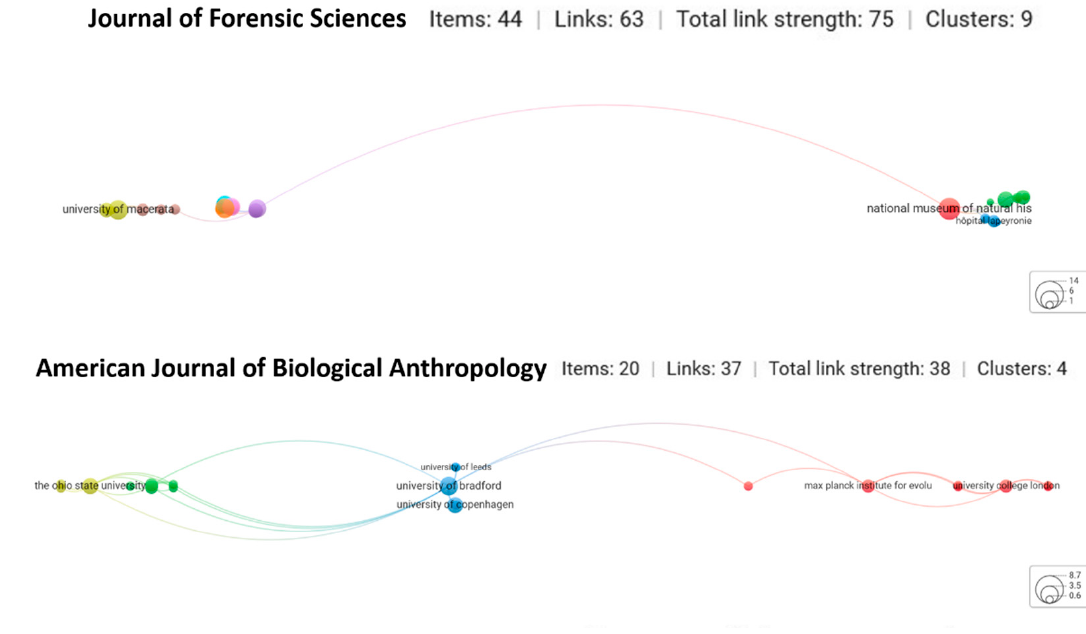
Figure 7. Network visualization of co-authorship by institutions for publications in the TOP4 journals. The interactable